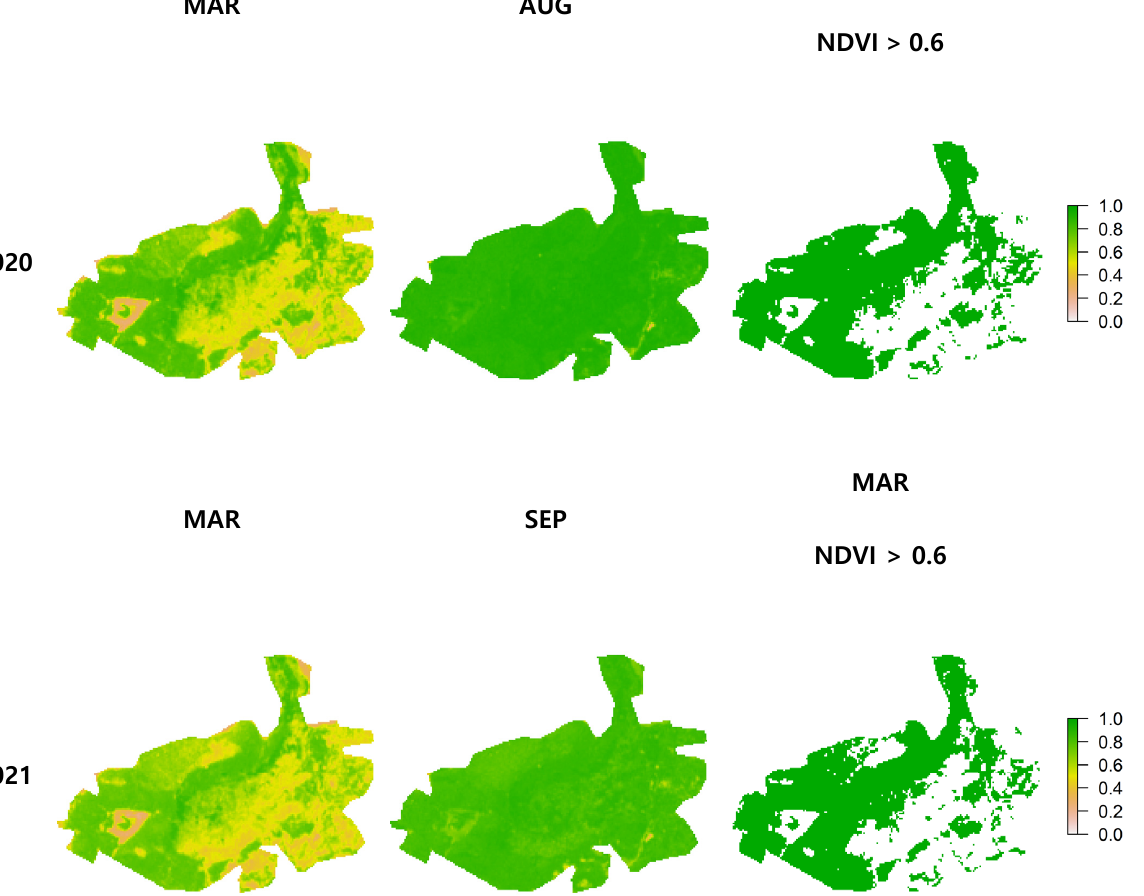
Figure 2. NDVI images of Geomunoreum in winter (the first column) and summer (the second column) for 2020 and 2021. The third column represents only pixels with an NDVI value greater than 0.6 in the NDVI image for March.